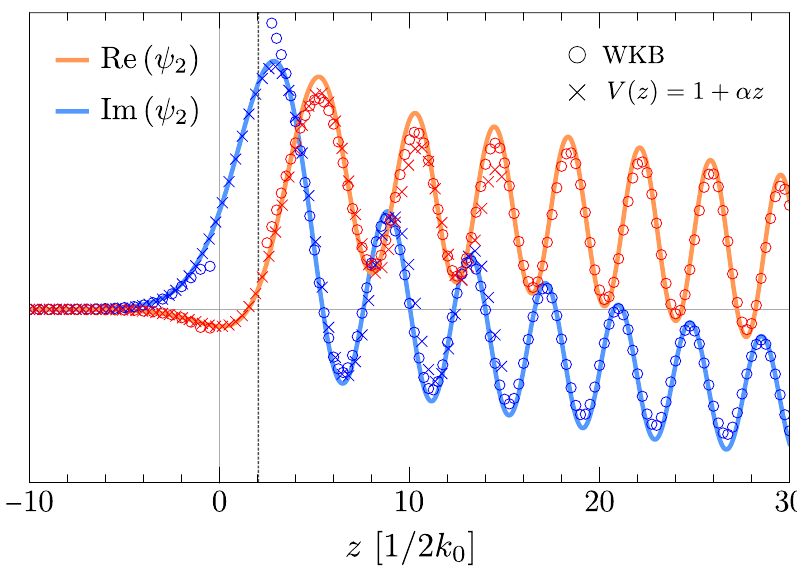
for the case of 2